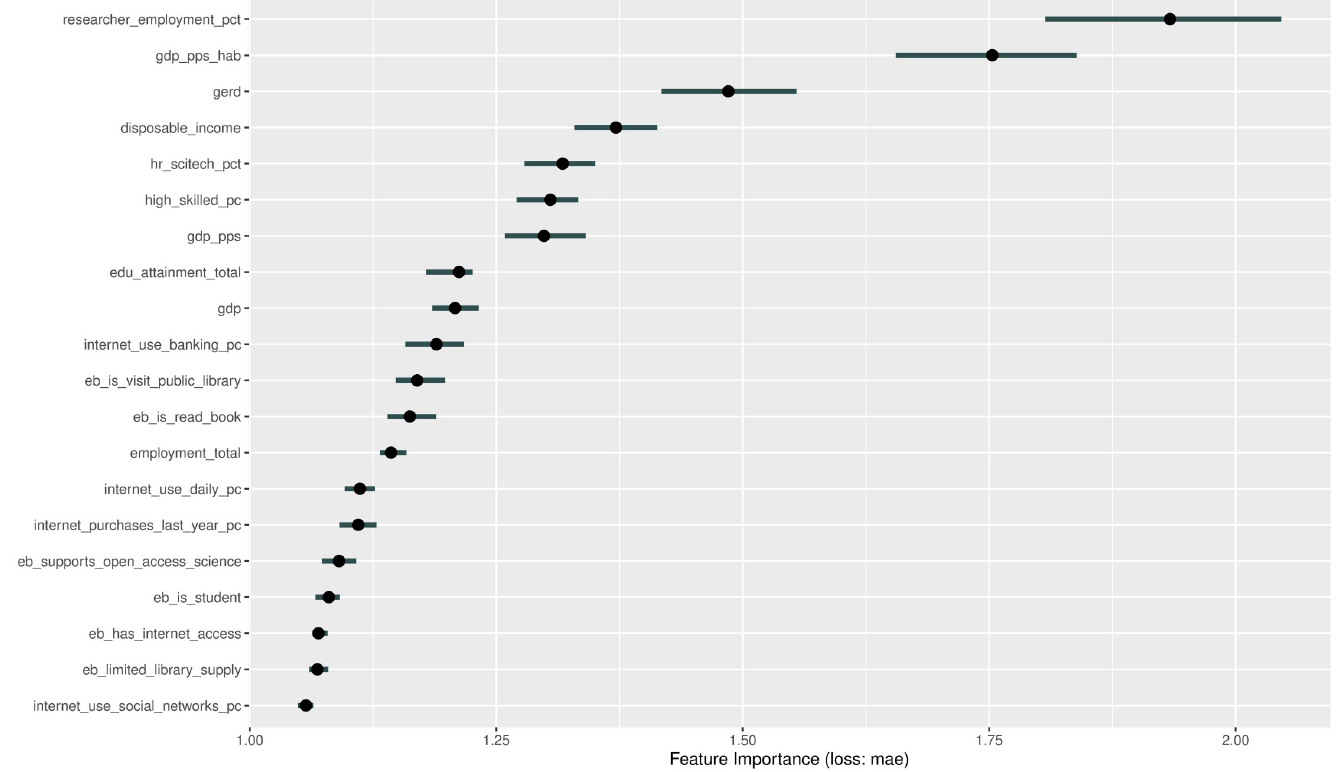
Fig 6. Random forest feature importance of EUROSTAT+EUROBAROMETER (DV: Count per capita, number of runs: 100).